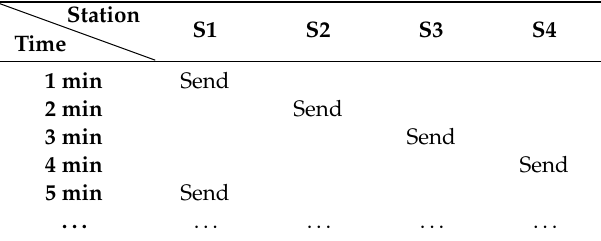
Table 2. Sound Transmission based on the round-robin